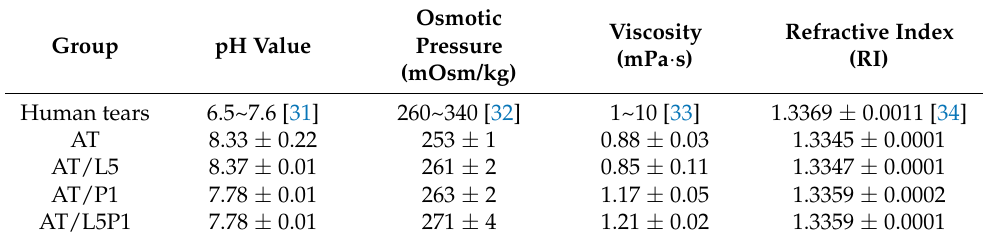
Table 1. Characteristics of artificial tears (AT) with variant lutein and PVA combinations.